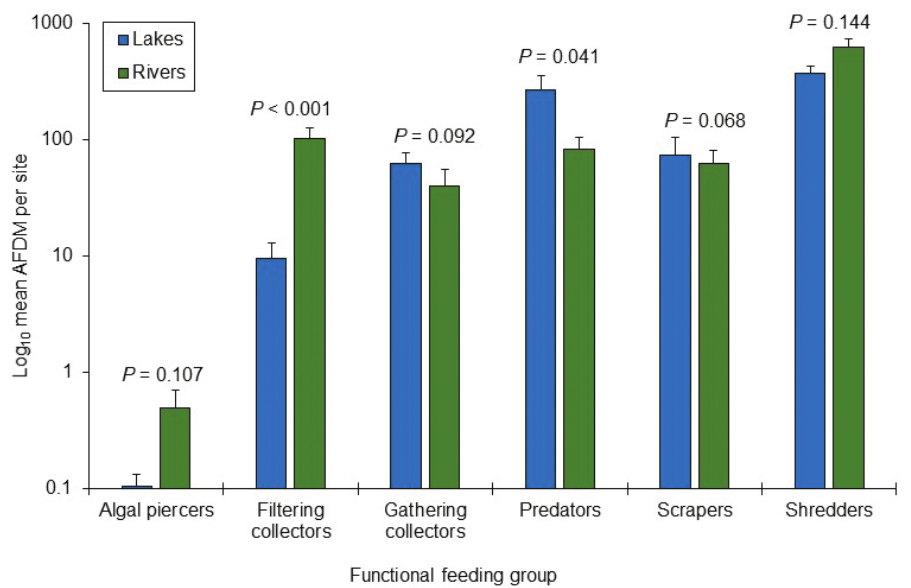
Figure 4. Log mean (+SE) total AFDM for caddisfly FFGs between lakes and rivers of the Huron 10 Mountains. P -values based on nonparametric Mann-Whitney U -tests of the mean biomass for each FFG between lake and river habitats. N = six for lakes and 12 for